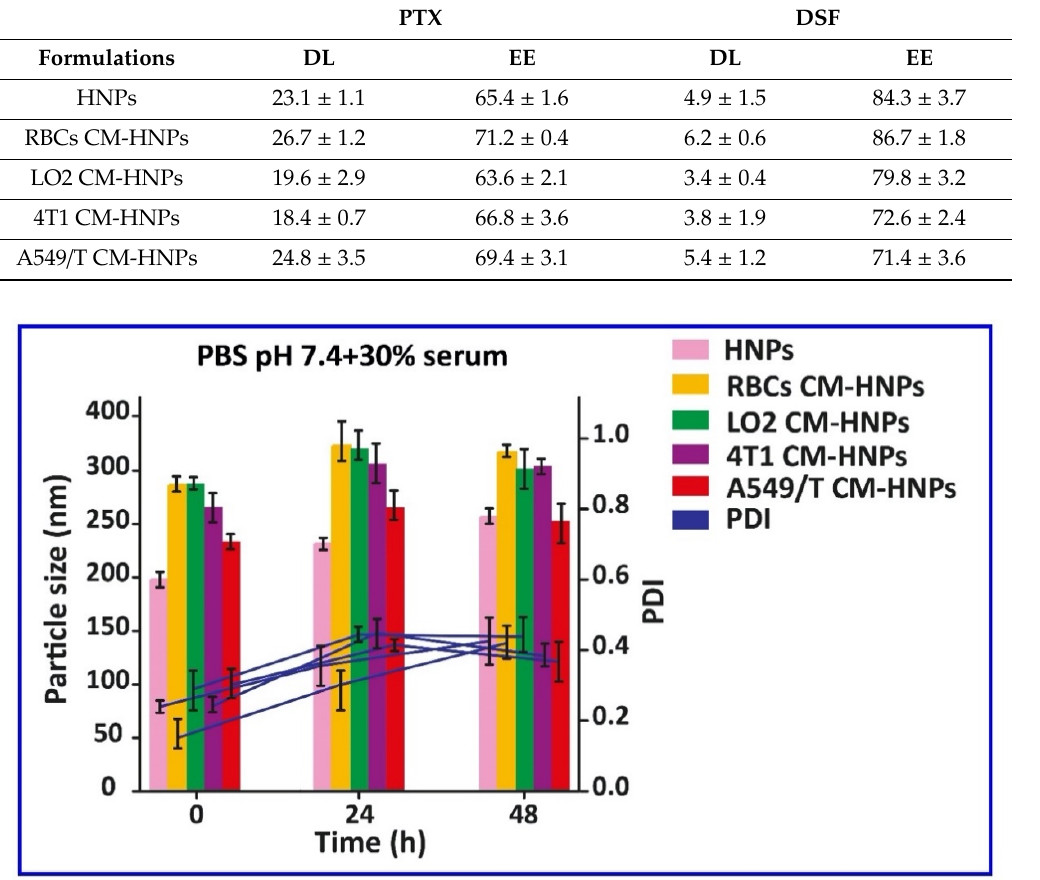
Figure 6. Stability HNPs, RBC CM-HNPs, LO2 CM-HNPs, 4T1 CM-HNPs, and A549/T CM-HNPs in PBS (pH 7.4) + 30% FBS over a span of 48 h.